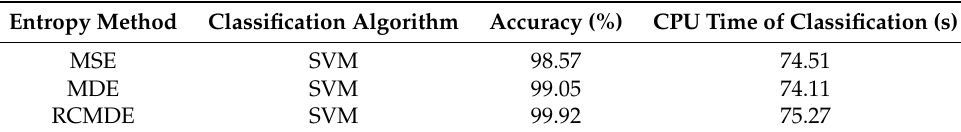
Figure 5. Entropy distribution of all samples (scale = 15): ( a ) MSE; ( b ) MDE; ( c ) RCMDE.